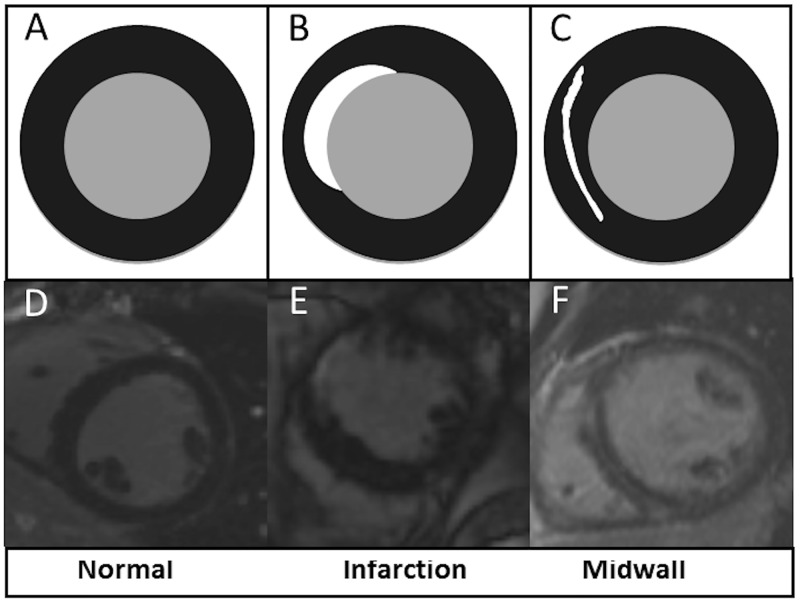
The top panels (A, B, C) represent graphical sketches of a mid-ventricular short axis slice through the myocardium using an inversion recovery sequence. The bottom panels (D, E,F) show the corresponding images obtained with CMR. Panels A and D show normal myocardium with no evidence of fibrosis (homogeneously black following gadolinium administration), panels B and E show infarction pattern fibrosis (subendocardial white enhancement following gadolinium administration) and panels C and F show midwall fibrosis (midwall enhancement following gadolinium administration with normal (black) myocardium both towards the epicardium and endocardium).